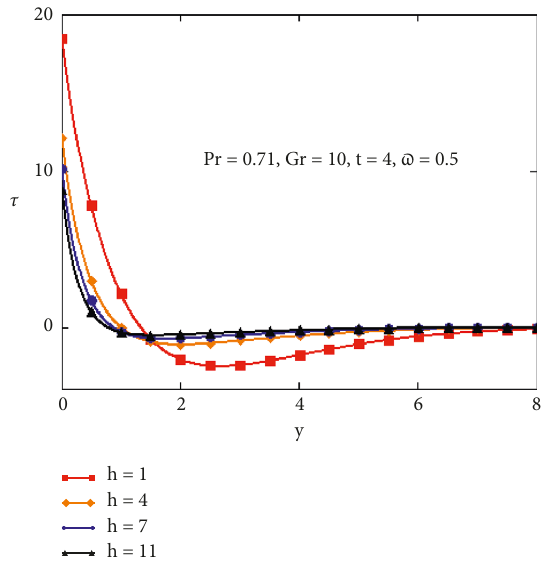
Figure 9: Skin friction profile for different values of h